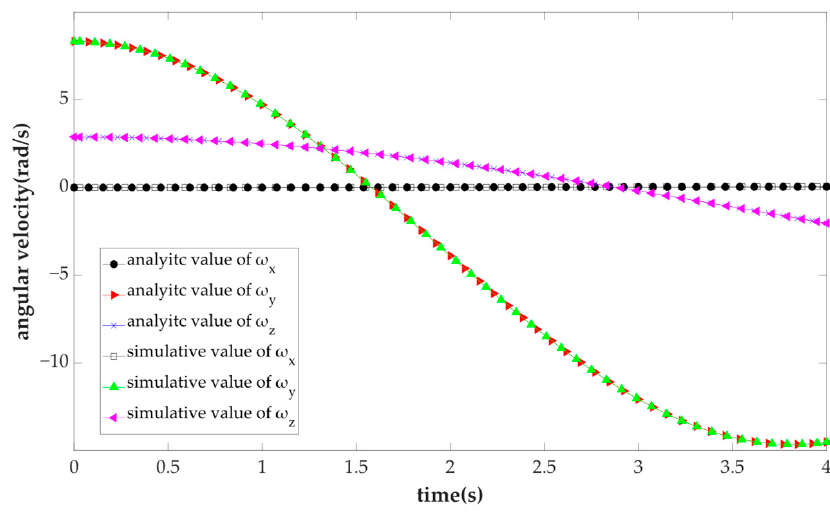
Figure 10. The comparison between analytic results and simulative results of linear velocity of m .